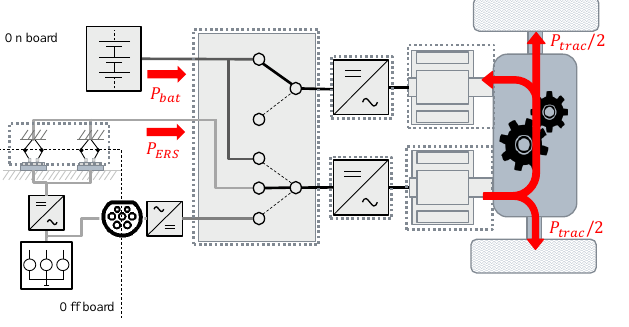
Figure 11. The energy flow illustrated while charging and while positive torque is applied to the